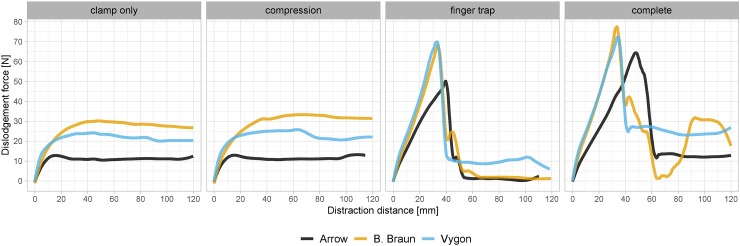
Distance-force diagrams.Median forces and distances of all investigated fixation suture techniques. A steady state of dislodgement force occurs in the “clamp only” and “compression” fixation technique. The catheter is being pulled throughout the fixation clamp in these two approaches. In contrast, the dislodgement force increases steadily in the “finger trap” and “complete” fixation technique until a rupture of the suture or catheter occurs. After the rupture, the dislodgement force is close to zero in the “finger trap” approach since no clamp is being used. In contrast, the dislodgement force in the “complete” fixation technique is similar to the “clamp only” and “compression” approach since the catheter is still secured by the clamp after the rupture of suture. The second peak observed in “finger trap” and “complete” technique of Arrow and B. Braun appears when the catheter ruptured before the suture.